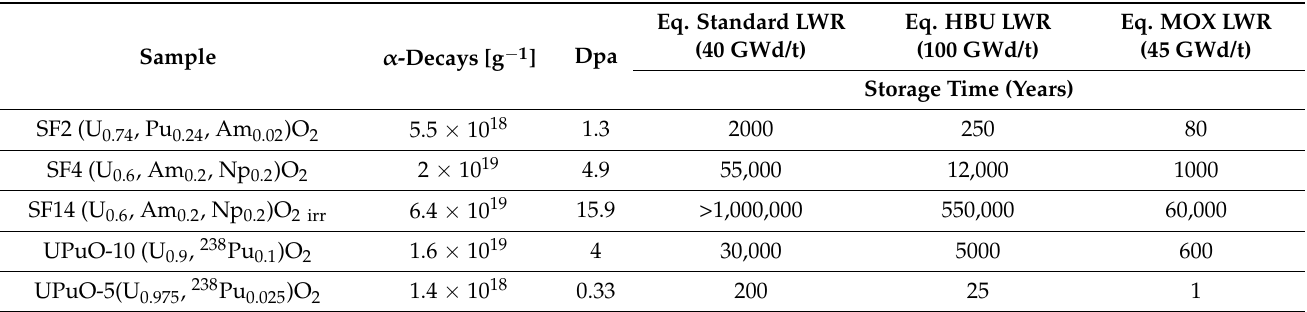
Table 1. Samples studied with the cumulated alpha dose and damage and their equivalent storage time for several types of LWR